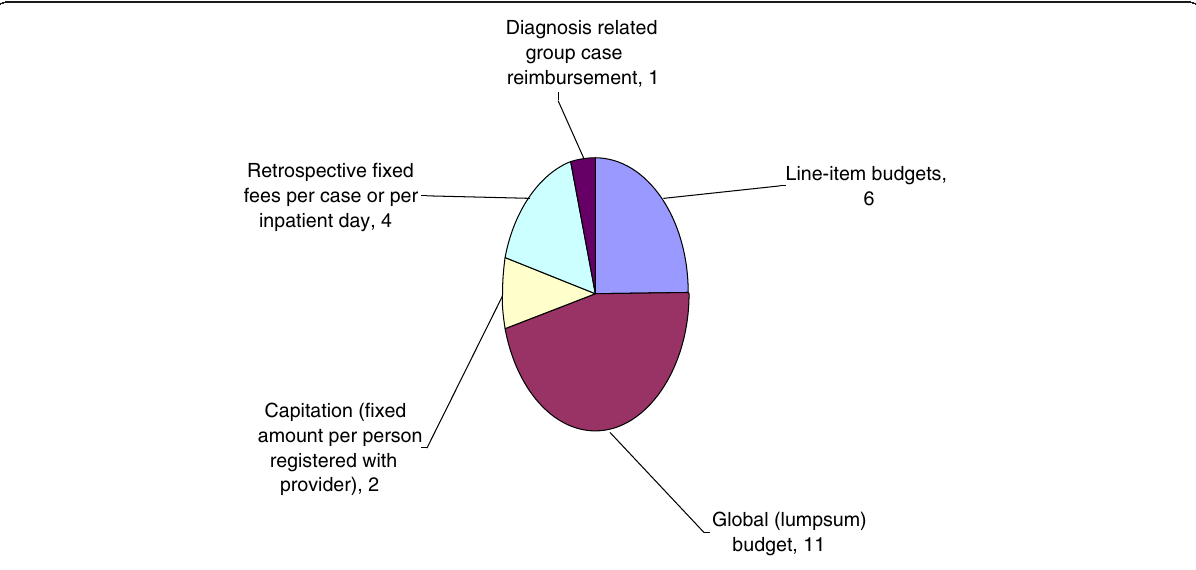
Figure 5 Number of respondents voting for provider payment